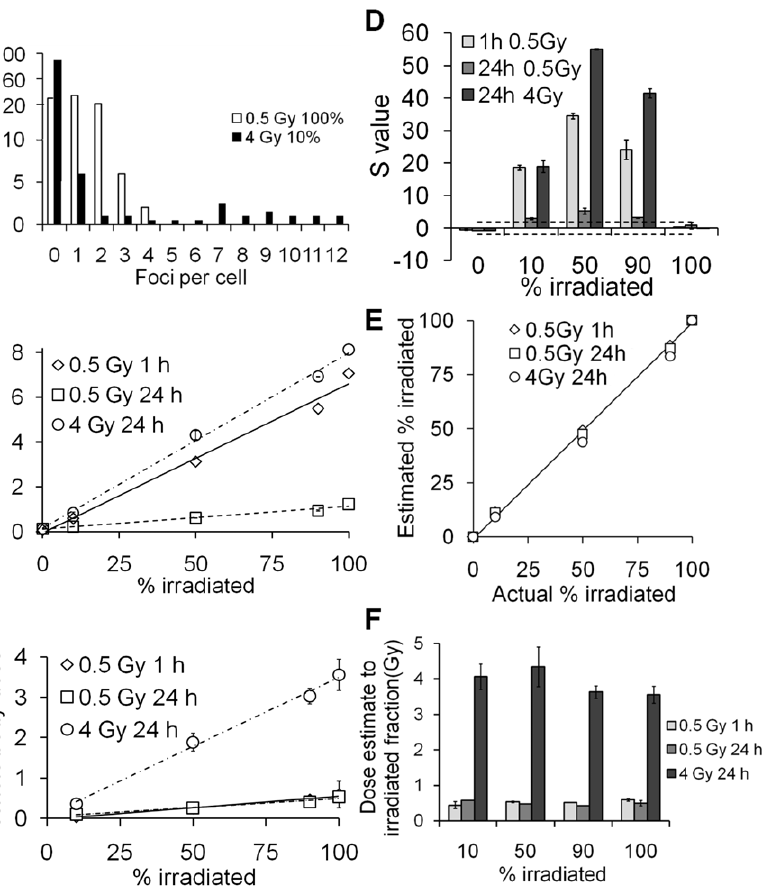
Figure 3. c -H2AX foci analysis of a mixture of irradiated and unirradiated lymphocytes. (A) c -H2AX foci distribution at 24 hours after exposure of 100% of the cells to 0.5 Gy or 10% of the cells to 4 Gy; mean foci per cell were 0.975 and 0.905, respectively. Note the logarithmic y-axis scale. (B) Mean c -H2AX foci per cell as a function of the irradiated fraction. Linear regressions were fitted to all data points. (C) Equivalent whole body dose estimates based on mean foci counts from Figure 3B and foci calibration curve presented in Figure 1E. (D) Poisson S values calculated for c - H2AX foci distributions in partially irradiated lymphocytes. Dashed lines mark the significance thresholds of 2 1.96 and 1.96. (E) Estimated versus actual irradiated fraction for the different simulated partial body exposures. Estimated fraction was calculated using the contaminated Poisson method. The line indicates a one-to-one correlation. Values have been corrected for background. (F) Dose estimates to the irradiated fraction.